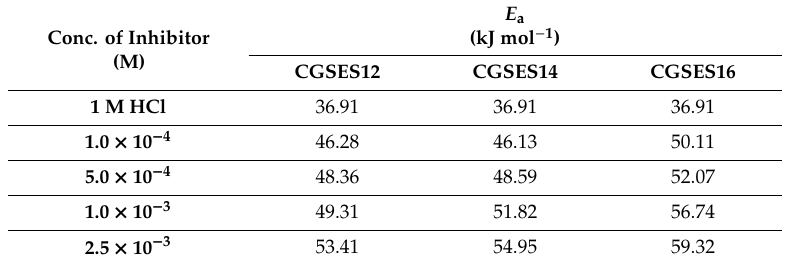
Table 8. Activation energy ( E a , kJ mol − 1 ) values for MS in 1 M HCl in the absence and presence of di ff erent concentrations of the synthesized cationic gemini surfactants.